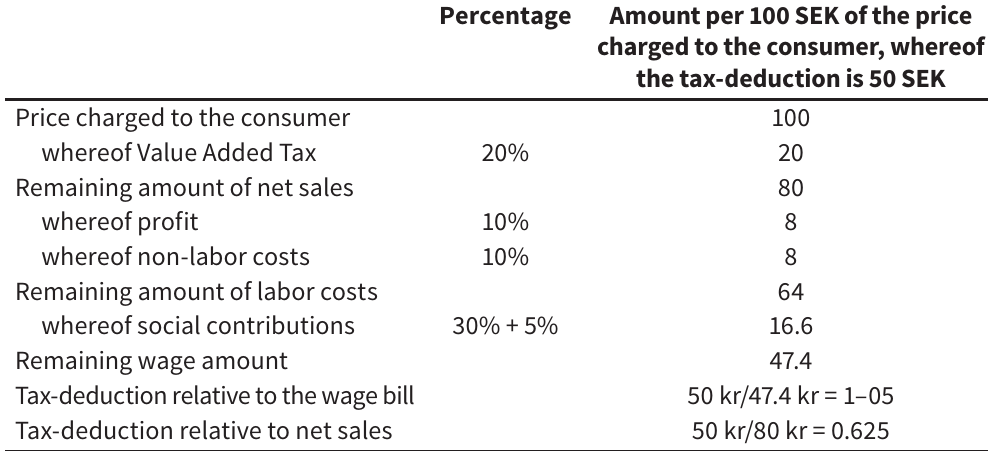
Assumptions about the sub-components in the price of domestic services. Percentage Amount per 100 SEK of the price charged to the consumer, whereof the tax-deduction is 50